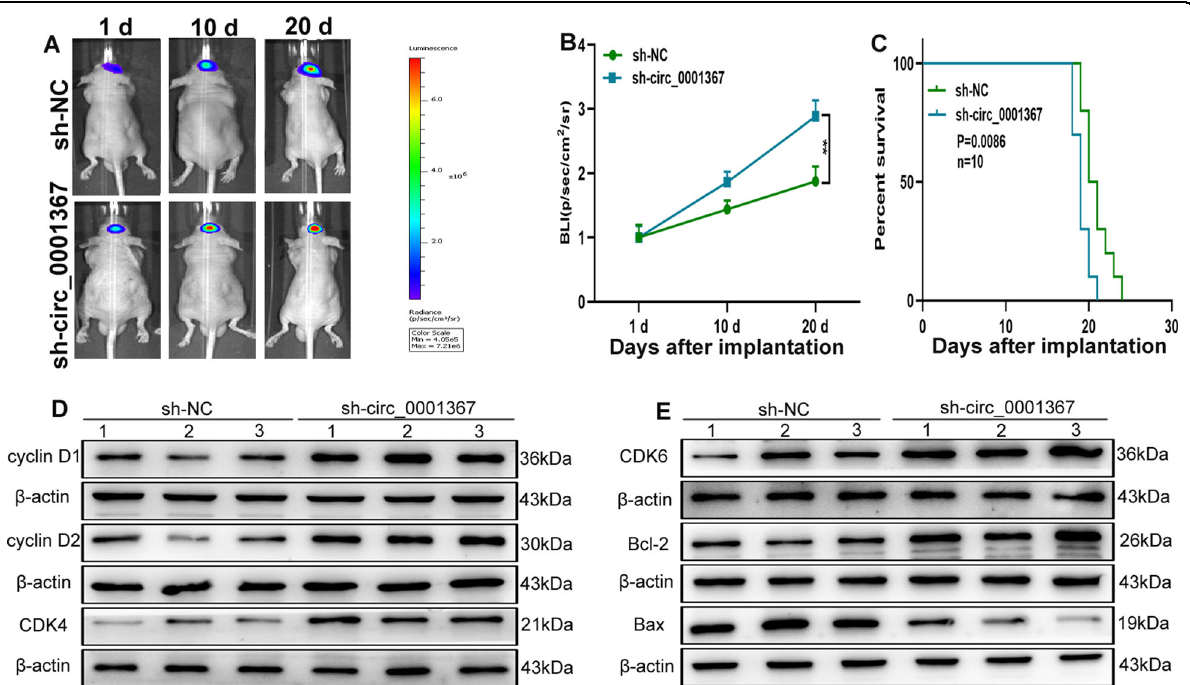
Fig. 3 Silencing circ_0001367 promotes glioma growth in vivo. A , B Bioluminescent images of the intracerebral tumours of nude mice (10 mice in per group) on days 1, 10, and 20 after stereotaxic orthotopic implantation of glioma cells. C Overall survival was compared between the sh- circ_0001367 and sh-NC groups by Kaplan – Meier survival analysis. D , E The expression of proliferation- and apoptosis-related proteins was detected by western blot analysis. Data are expressed as mean ± SD, ** P <